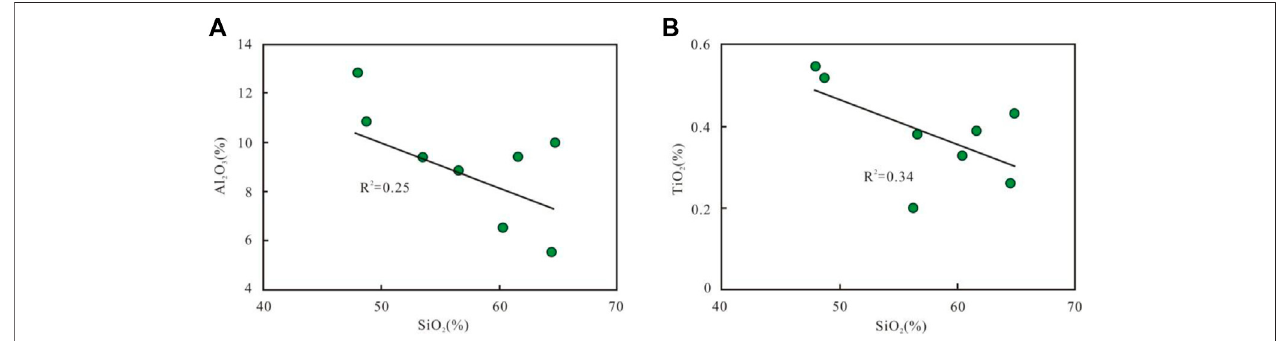
FIGURE 7 | (A) Negative correlation between SiO 2 and Al 2 O 3 contents. (B) Negative correlation between SiO 2 and TiO 2 contents.